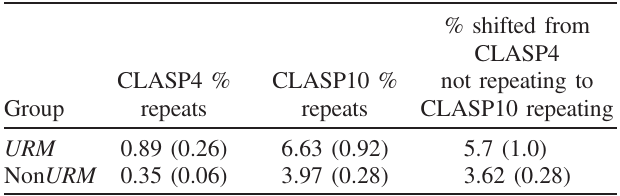
TABLE X. Percentage of student repeats after taking a course from our dataset. We give results for each grade scale and also the number that would seem to be shifted from not repeating a course under CLASP4 to repeating the course under CLASP10. Standard errors are shown in parentheses.